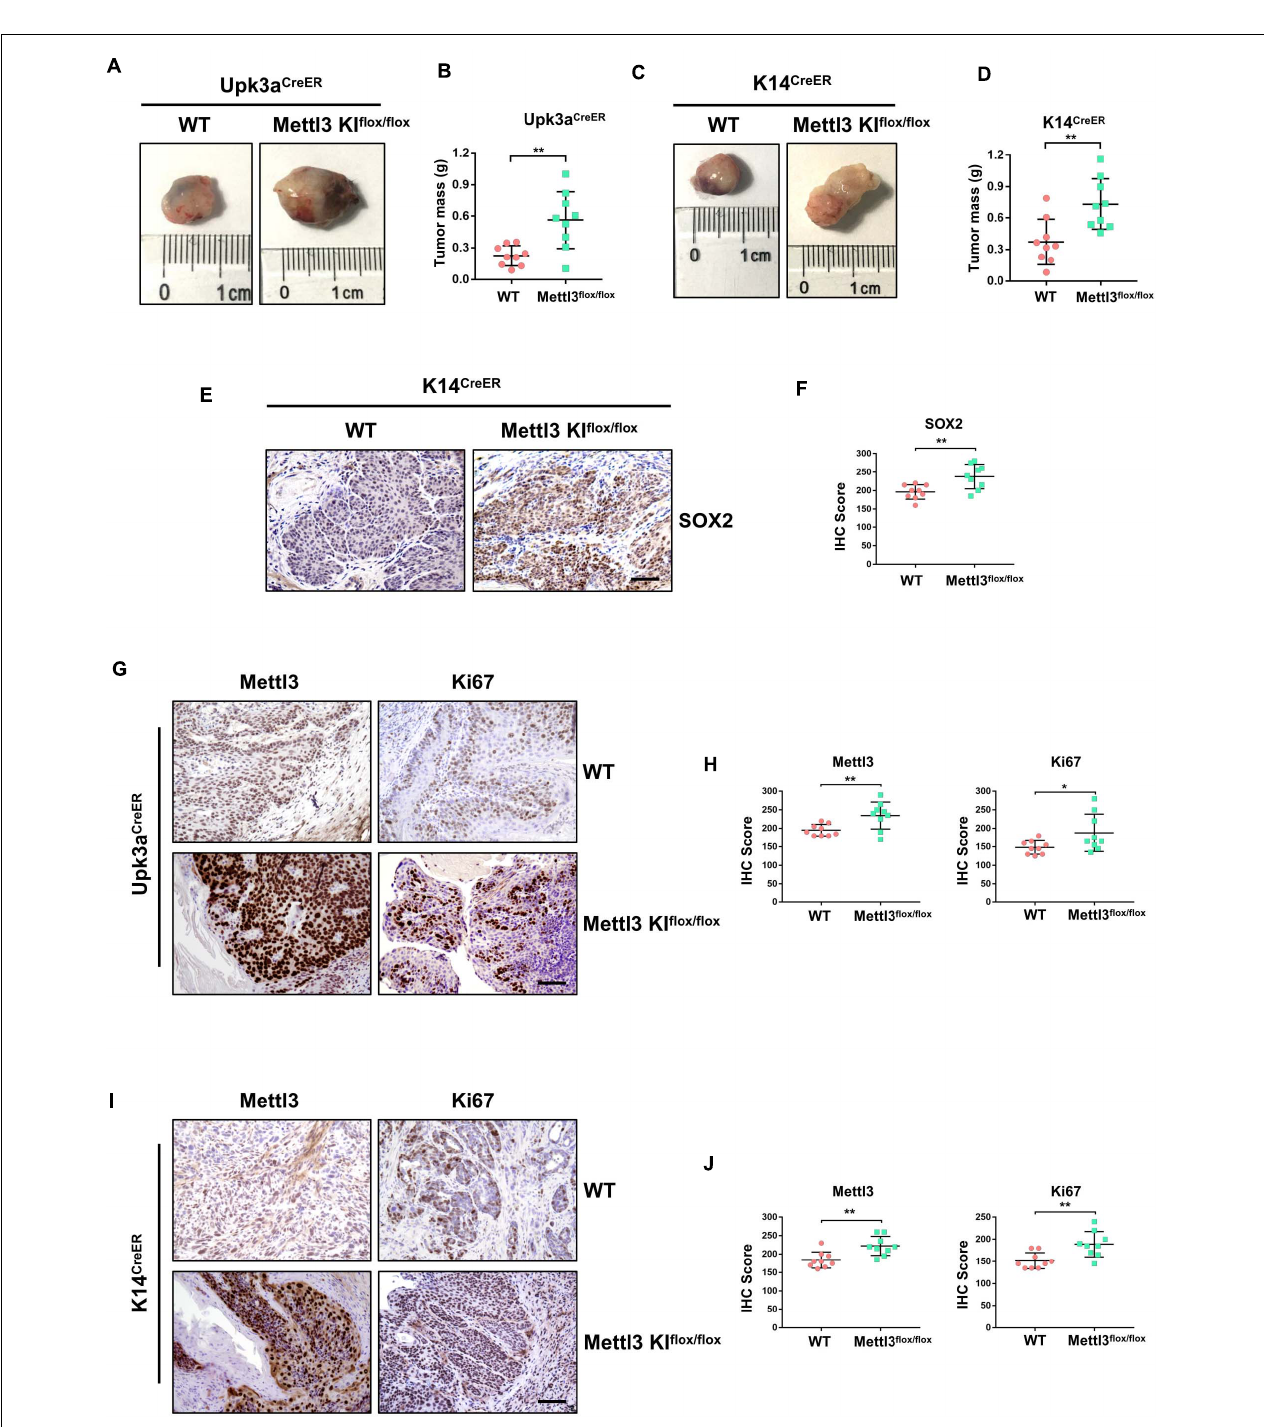
FIGURE 3 | Overexpression of Mettl3 in urothelium or K14 + cells promotes bladder cancer (BCa) progression in vivo . (A) Representative images of BCa in Upk3a CreER WT (left) and Upk3a CreER Mettl3 KI (right) mice showing the tumor volume. (B) Measurement of tumor mass in Upk3a-specific WT and Mettl3 KI groups, respectively. (C) Tumor volume was shown in K14-specific WT (left) and KI (right) mice. (D) The weight of tumor collected from K14 CreER wild-type and K14 CreER Mettl3 KI mice was calculated, respectively. (E) immunohistochemistry (IHC) staining showing SOX2 expression in WT and Mettl3 KI flox / flox mice. Scale bars, 100 µ m. (F) The IHC score was computed according to the intensity and frequency of SOX2 expression. (G) Immunostaining was applied to explore the expression level of Mettl3 and Ki67 in Upk3a CreER WT or Mettl3 KI mice. Scale bars 100 µ m. (H) IHC scoring was calculated based on the statistics of staining intensity and ratio of positive cells above. (I) Representative IHC staining images of Mettl3 or Ki67 in K14 CreER wild-type and K14 CreER Mettl3 KI mice. Scale bars, 100 µ m. (J) Calculation of IHC scores according to the immunostaining images above. * p < 0.05; ** p < 0.01.